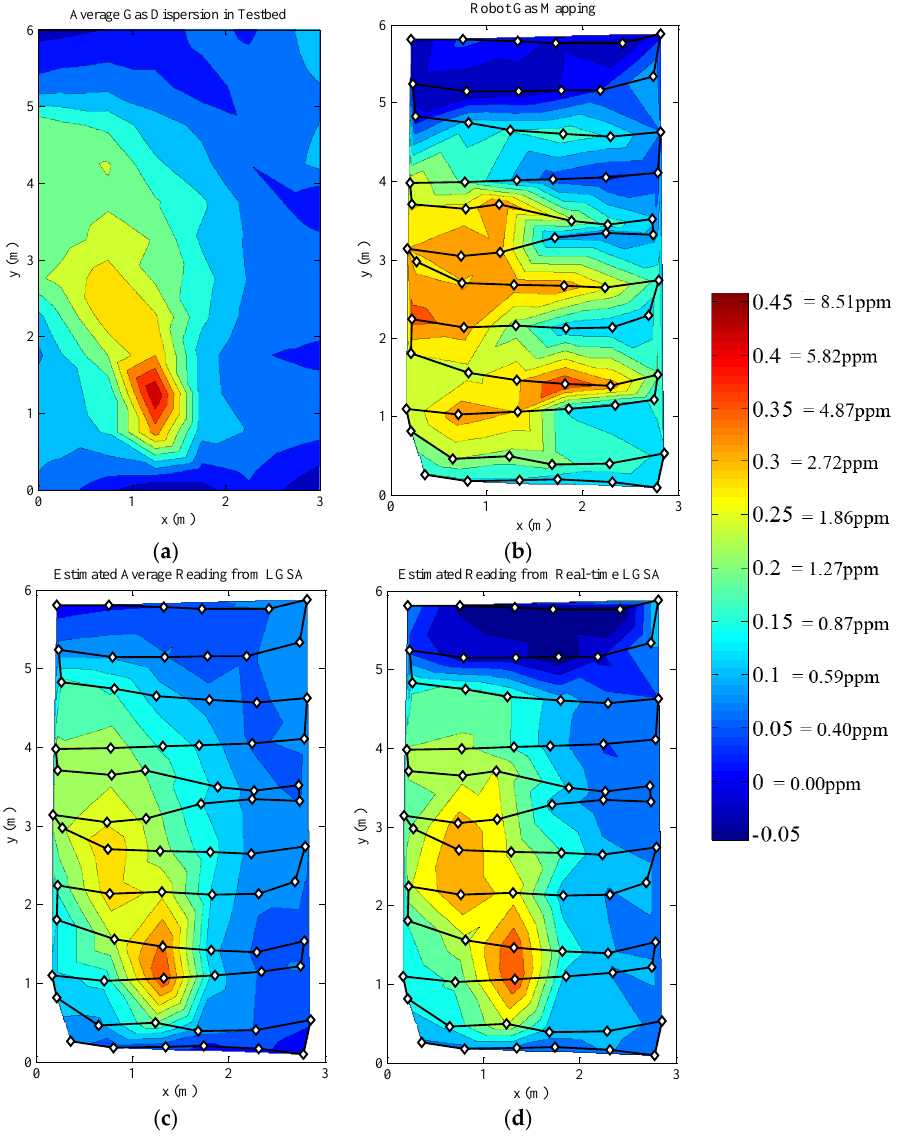
Figure 17. Gas distribution plots of stop–start robot experiment. The robot’s movement path is denoted by the line and the dots indicate measurement point. The robot starts at the top right corner of the map. ( a ) The averaged LGSA reading for the duration of the experiment; ( b ) The measured gas concentration by the robot; ( c ) The ground truth robot reading estimated from the averaged LGSA measurement; ( d ) The ground truth robot reading estimated from the real-time LGSA measurements.